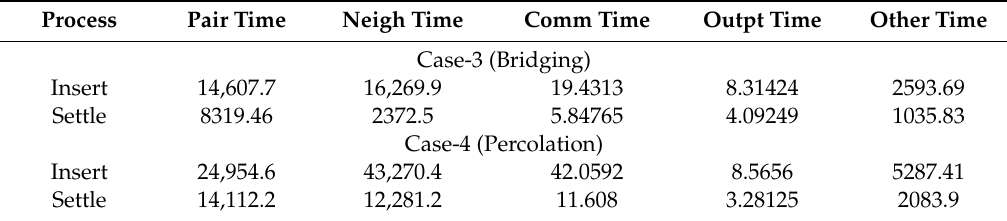
Table 3. Time consuming each process for two cases of infiltration